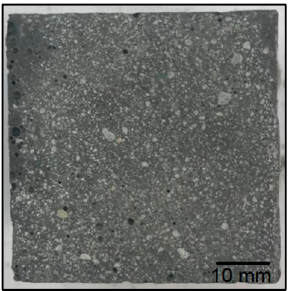
Figure 11. Breakthrough of the reference sample.